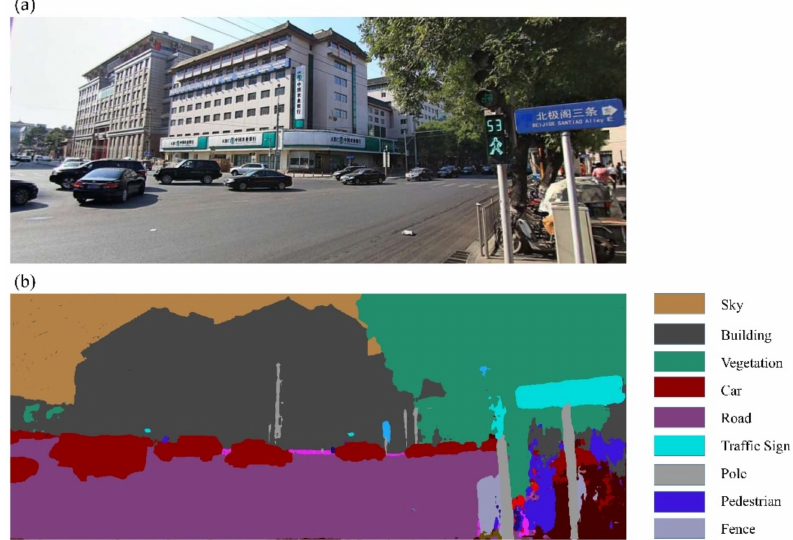
Figure 3. An example of the semantic image segmentation results. ( a ) The original image and ( b ) the segmented